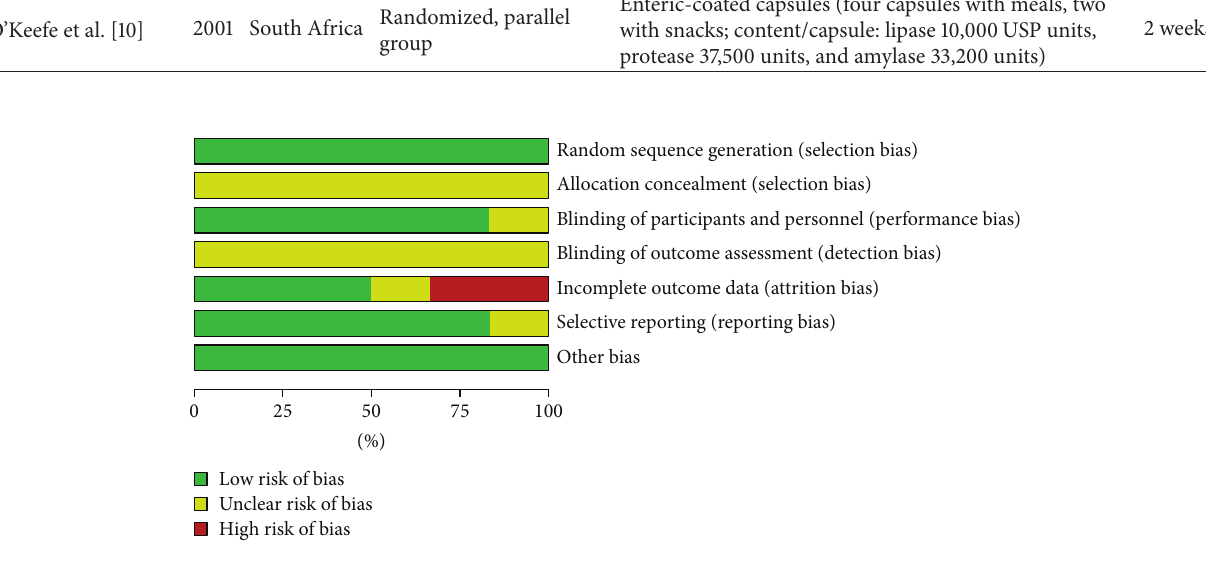
Figure 2: Risk of bias